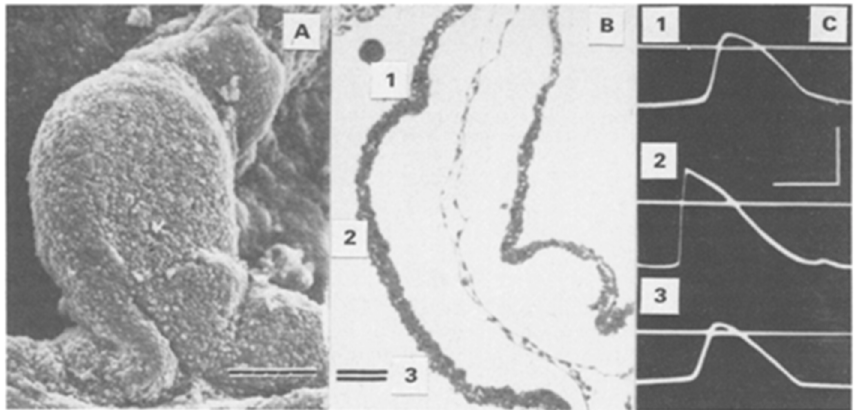
Figure 2. Early heart action potentials. Action potentials captured by electrodes placed on the early embryonic chicken heart [39]. ( A ) A scanning electron micrograph of the tubular heart (bar = 100 m) at 35 h (around stage 10); ( B ) Histological section of the same stage heart showing the myocardial wall to be two cells thick with a cardiac jelly separating it from the endocardial epithelium; ( C ) Resting membrane potentials (scale bars are 100 ms in time) and action potentials (APs) are 20 mV from the sites (1–3) labeled in panel B. At 40 h (stage 11) there is a change in AP morphology at site 2 showing a faster upstroke and a higher amplitude.